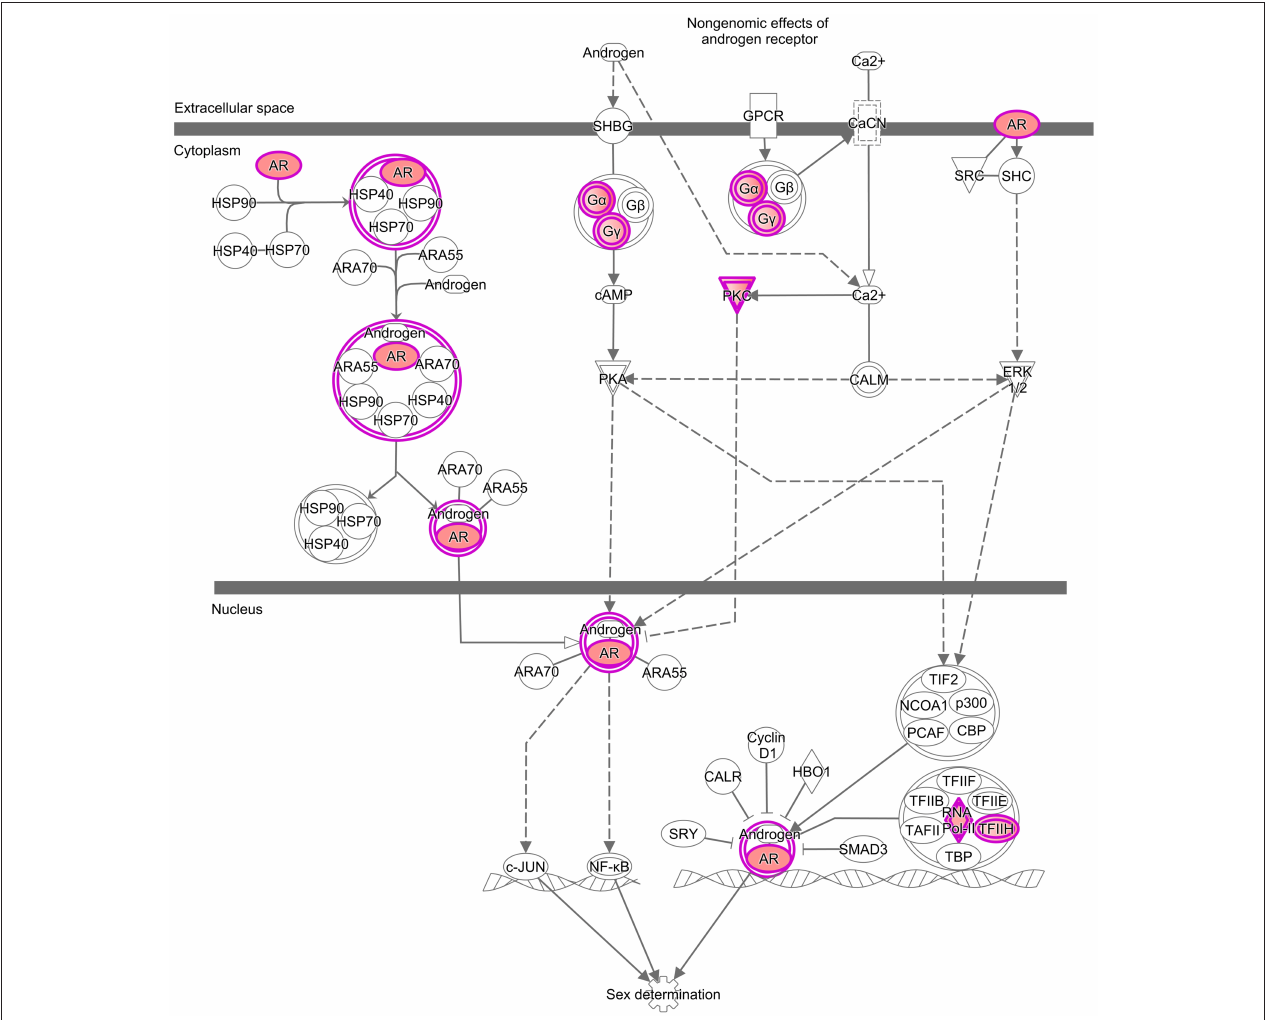
FIGURE 2 | Enrichments analysis and IPA ® pathways highlighting trends in granulosa cells from primordial and primary follicles, respectively. Pathway analysis (IPA ® ) of the “Androgen Signaling” pathway in granulosa cells of the primordial follicle. Color intensities are based on FPKM values where high significance is most intensive in color